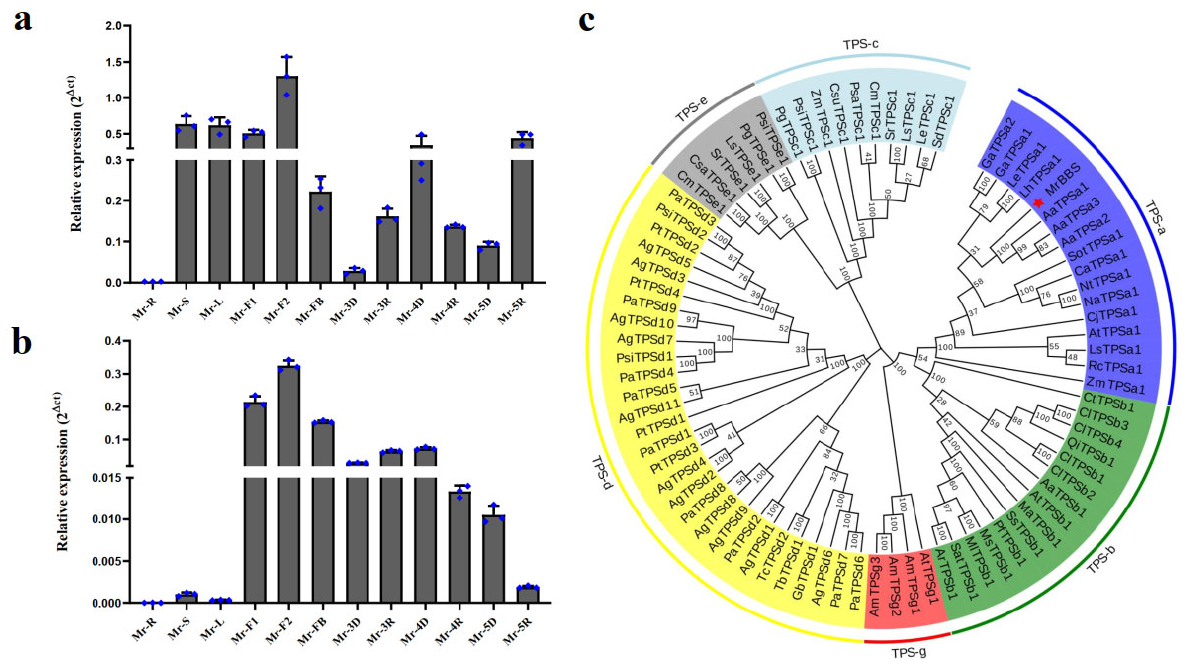
Figure 6. Expression patterns of MrFPS ( a ) and MrBBS ( b ) in German chamomile, and phylogenet ‐ ic tree analysis of MrBBS in German chamomile ( c ). Each point represents one independent meas ‐